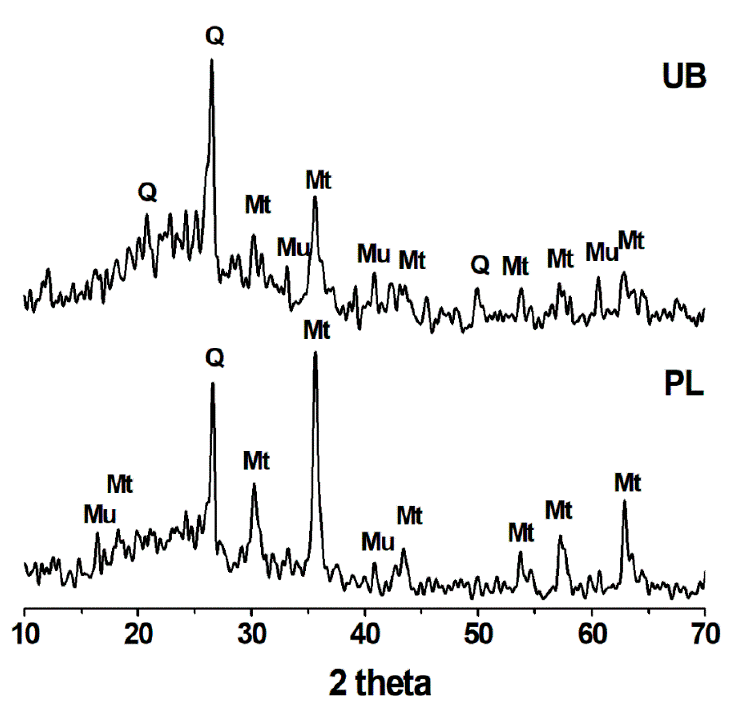
Figure 3. results of XRD Analysis of the UB and PL samples. Mu: Mullite; Mt: Magnetite; Q: Quartz. Table 3. Trace elements concentrations (ppm) in magnetic fractions of UB and PL fly ashes as determined ICP-MS analysis.